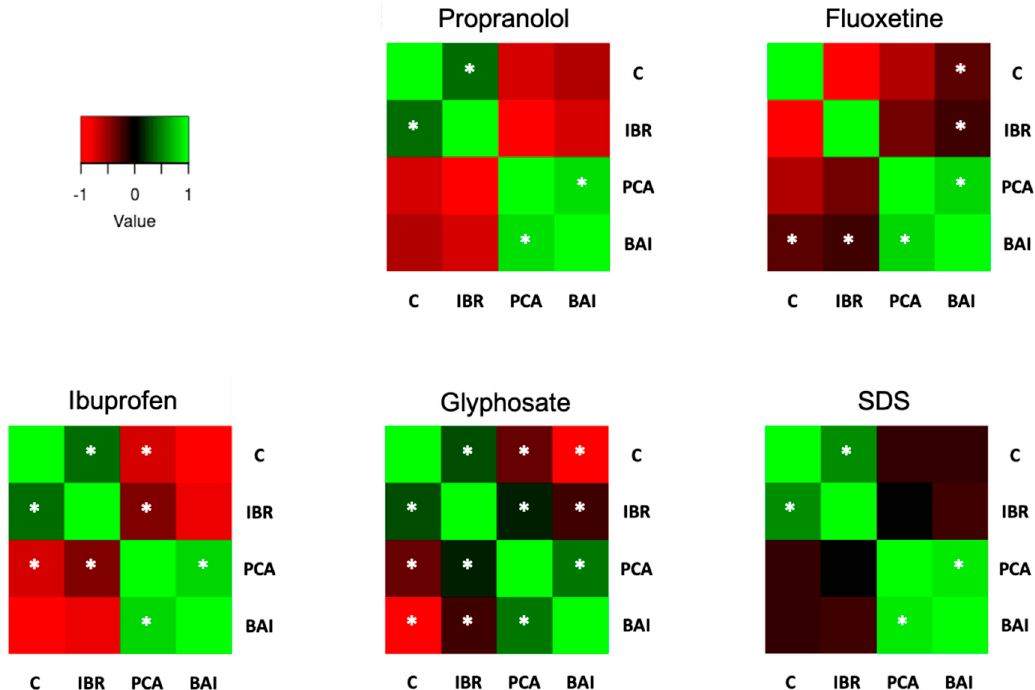
Figure 5. Spearman correlations heatmaps between the calculated index values and the applied exogenous concentrations for each applied compound. (*) denote significant differences at p < 0.05 for all tested compounds. Indexes include the integrated biomarker response (IBR) index; the principal component analysis (PCA)-based index; and the bioeffect assessment index (BAI), whilst (C) refers to the gradient of exposure concentration.